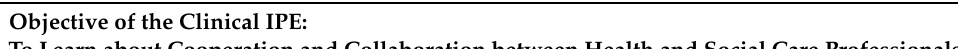
Table 1. Objectives and development of clinical IPE.